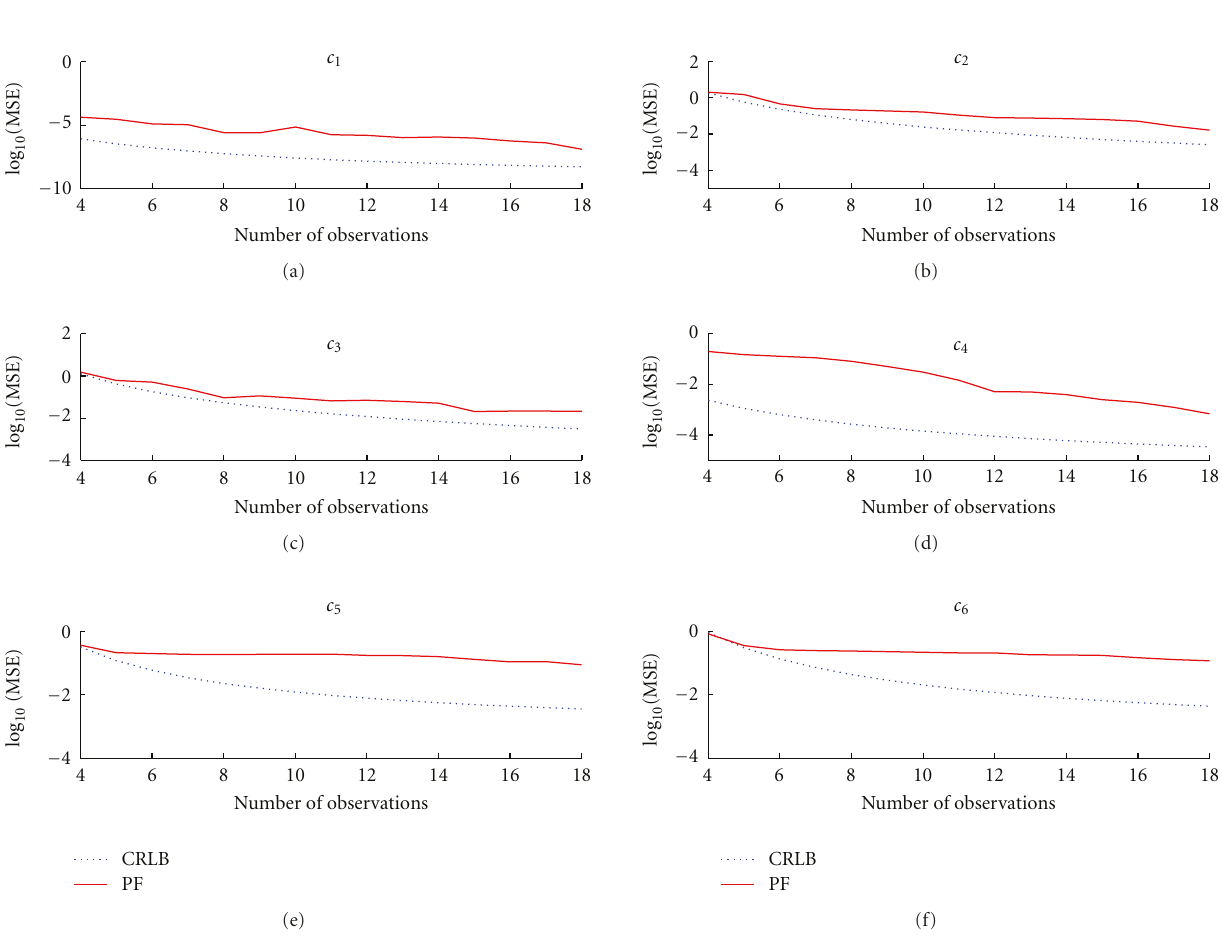
Figure 4: The CRLB and the average mean-square error of the particle filtering algorithm (the number of particles N s = 10 4 , noise covariance matrix Σ =